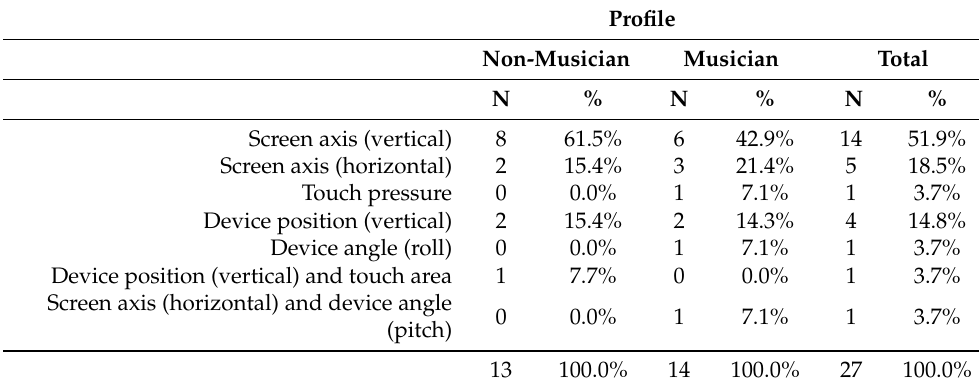
Table A3. Pitch variation mapping (uncategorized)—stimulus a.